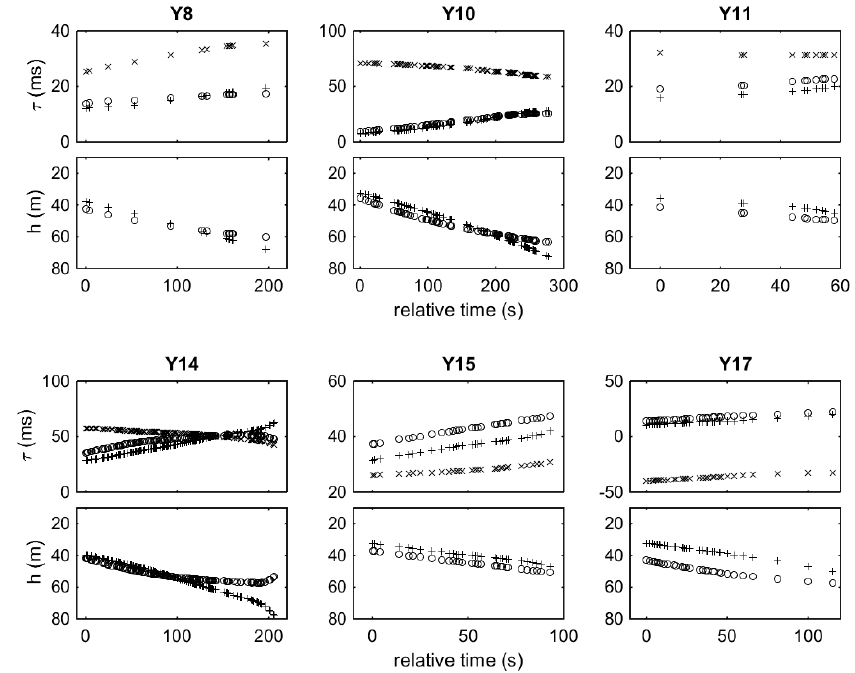
Figure 20. TDOAs of sperm-whale signals and hydrophone depths during stations Y8, Y10, Y11, Y14, Y15, and Y17 of the deep-water experiment on 8 June 2015 aiming at the localization of sperm whale Y for front hydrophone ( ◦ ), rear hydrophone (+) and τ 21 ( ×